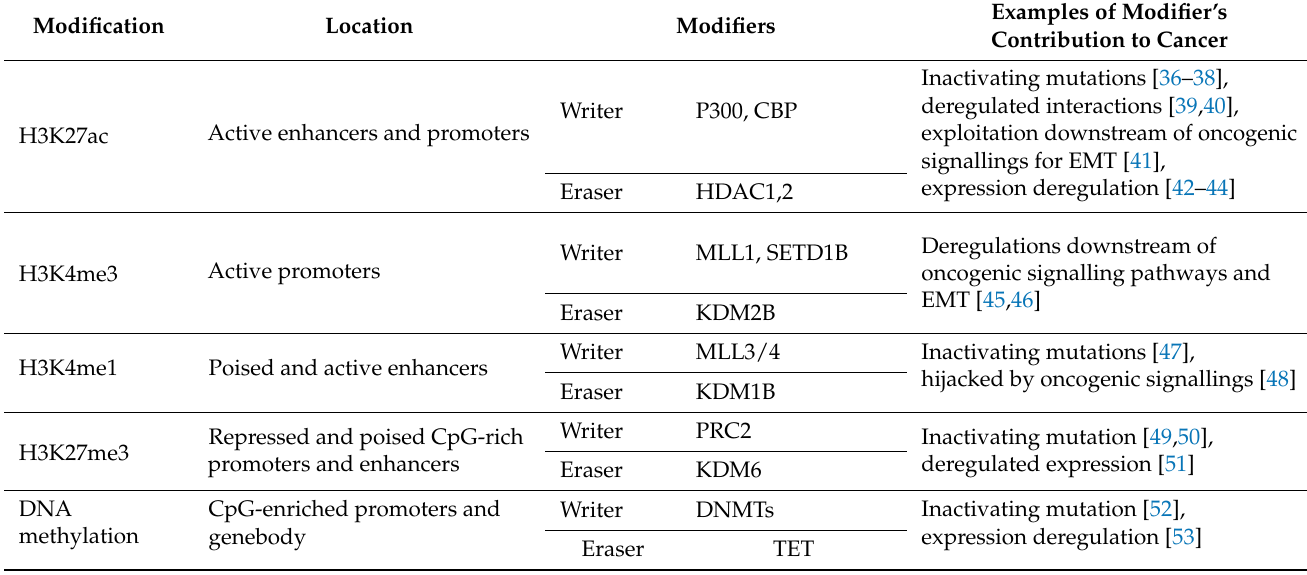
Table 1. Epigenetic modifications and the corresponding